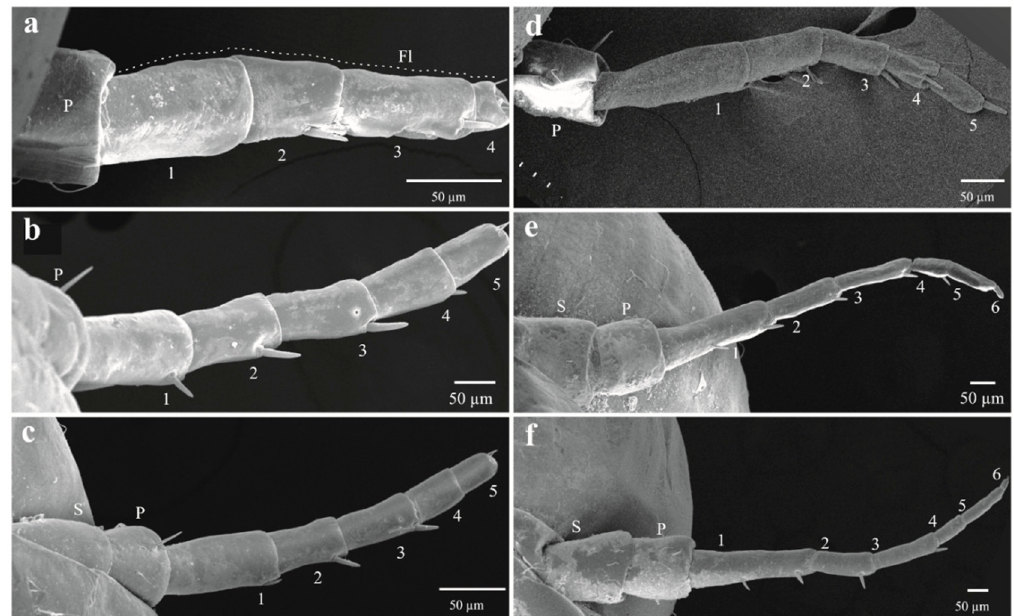
Figure 8. Antennae of the immature sages of Ocoaxo assimilis , corresponding to nymphal instar one to five (NI–NV). a) NI. b) NII, c) NIII, 21) NIV, d) NVa, and e,f) NVb. FL (flagellum), P (pedicel), S (scape). The number in antennal segments indicate the number of flagellomeres.